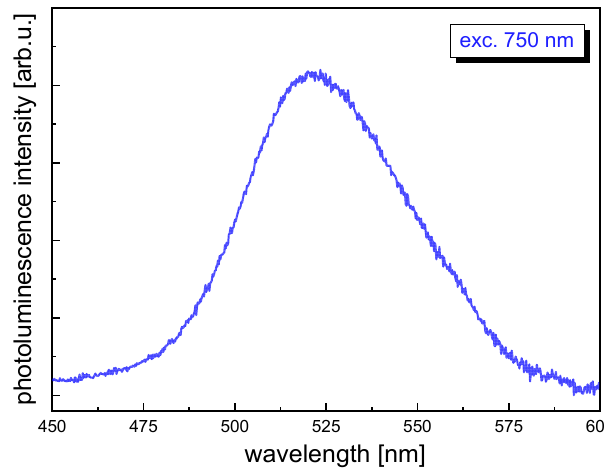
Figure 6. Representative photoluminescence spectra of CdS-5Au NPs upon two-photon 750 nm excitation.